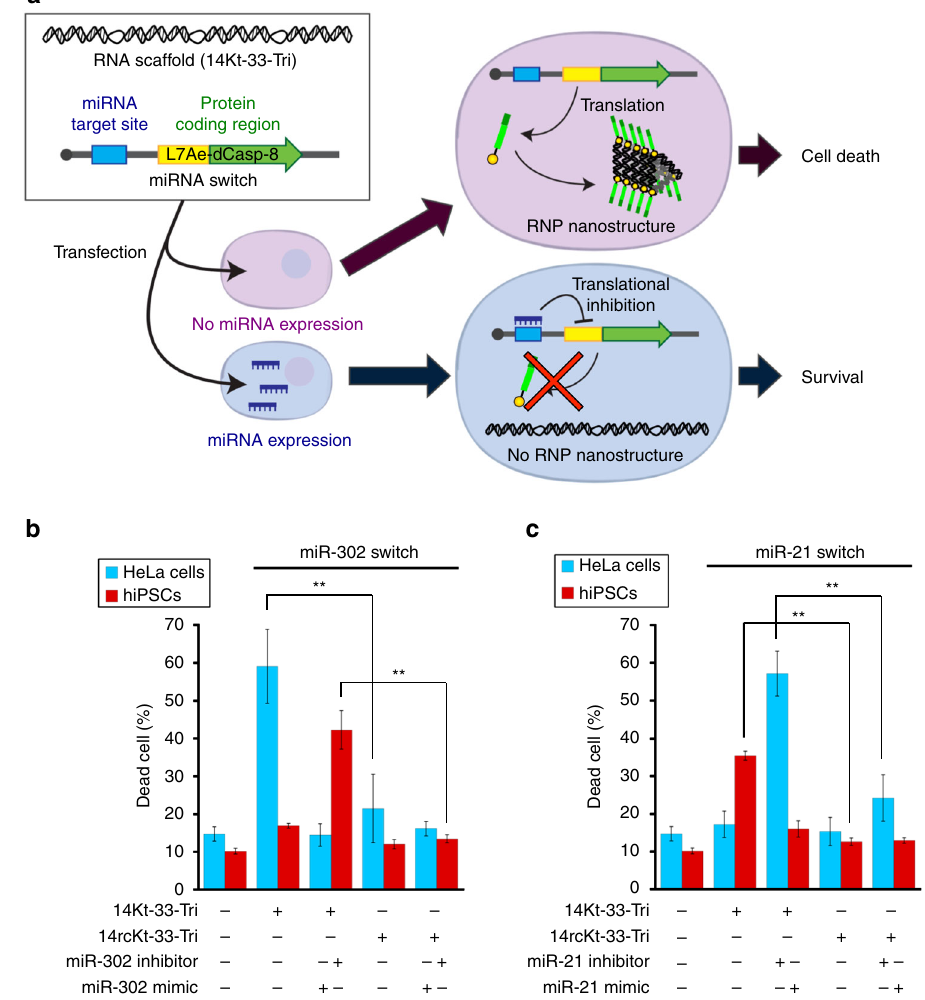
Fig. 6 RNP nanodevices that detect endogenous miRNAs and selectively control cell-death signals. a Schematic representation of miRNA-responsive cell- death control mediated by miRNA switches encoding L7Ae-dCasp-8 and RNA scaffolds. b , c Cell-death induction using miR-302 ( b ) and miR-21 ( c ) responsive switches encoding L7Ae-dCasp-8 and 14Kt-33-Tri (14rcKt-33-Tri) in HeLa cells ( blue ) and hiPSCs ( red ). The dead cells were stained with Paci fi c Blue Annexin V and analysed using fl ow cytometry. The data are presented as the mean ± SD ( n = 3). ** P < 0.01 (Welch ’ s t